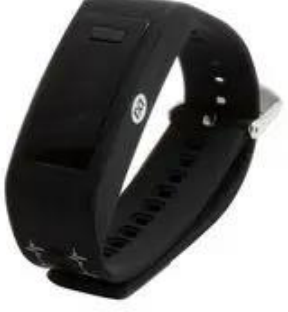
Figure 4. AliveCor Kardia Mobile device and its application.